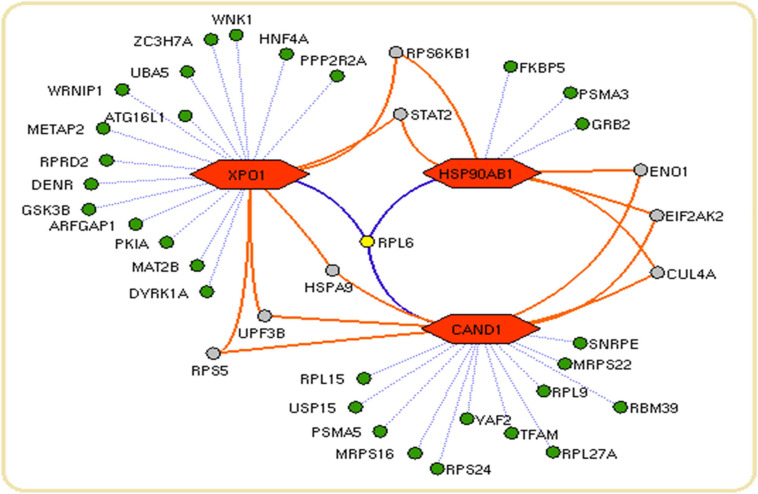
Network connectivity of hub proteins: The network showing the proteins (green nodes) with their connected interaction (dotted violet edges). The 60S ribosomal protein L6 (RPL6) (yellow node) with violet edges that connects core proteins (orange hexagon) of the hubs. The protein (gray node) connects a maximum of two core proteins (orange hexagon) in the network.